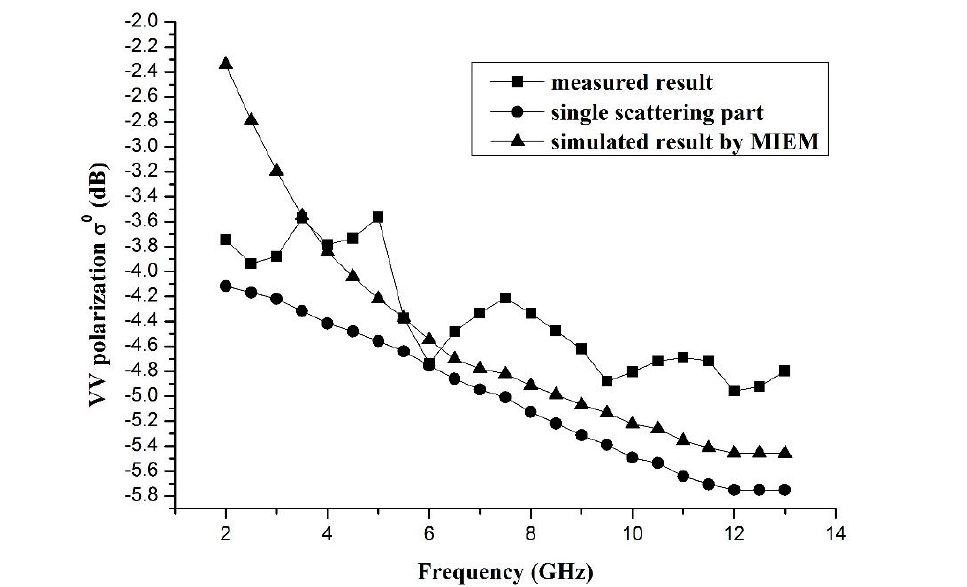
Figure 5. Importance of multiple scattering part based on MIEM (VV polarization, incidence angle = 30° , RMS height = 2.5 cm, correlation length = 6.0 cm), where square line is EMSL measured result, and circle line and triangle line represent single scattering part and simulated result by MIEM including multiple scattering